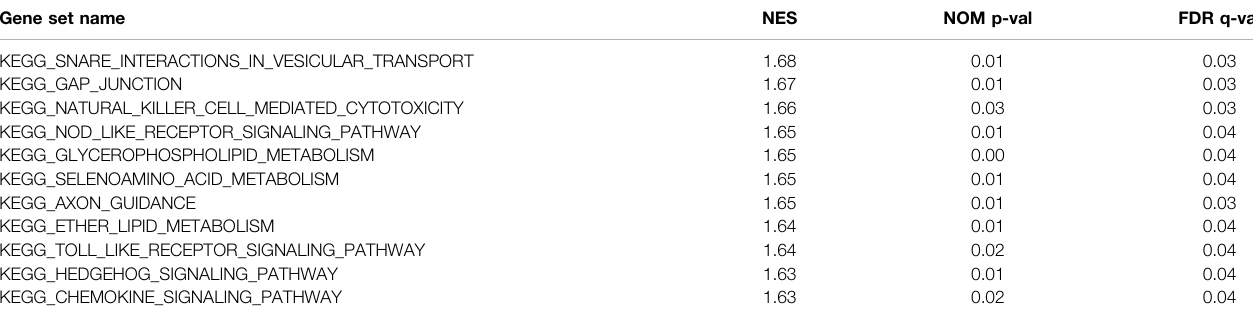
Sigma-Aldrich) ( Figure 6A ). In addition, the pattern of DEPDC1B expression in LIHC tissues is shown in Figure 6 . (strong: Figures 6B,C ; medium: Figures 6D,E ).